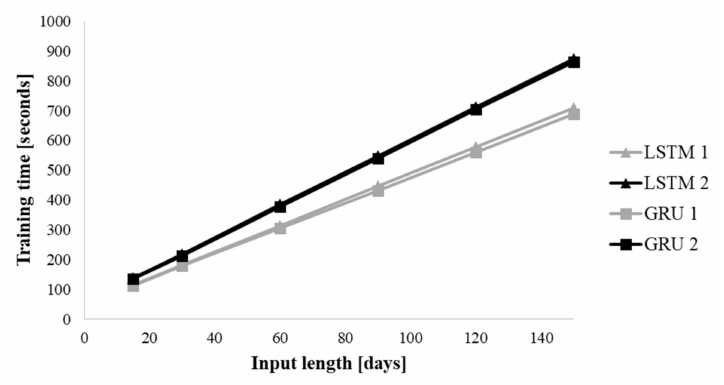
Figure 9. Training time of the